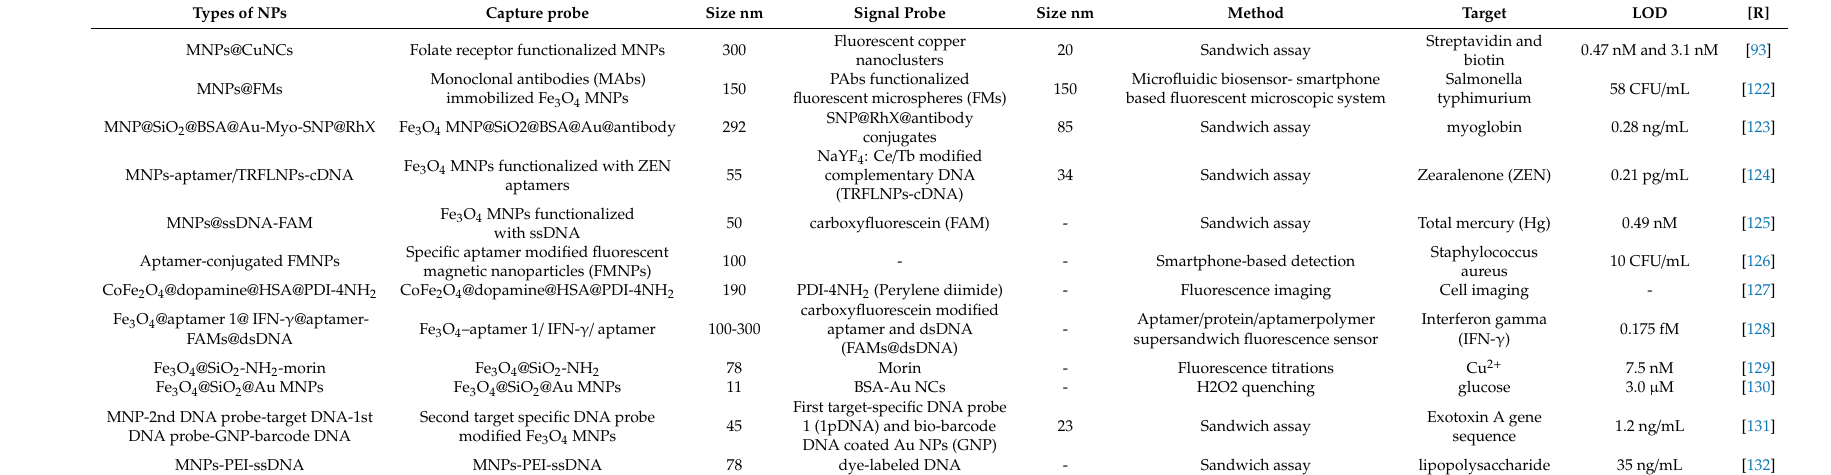
Table 3. Some examples of fluorescence-based MNPs